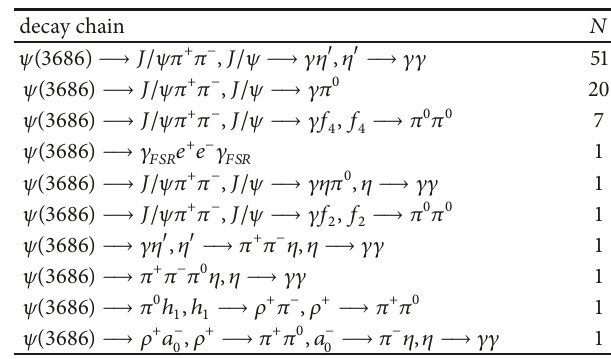
Table 1: The background of 𝐽/𝜓 󳨀→ 𝛾𝜂, 𝜂 󳨀→ 𝛾𝛾 . 𝑁 denotes the number of events passed from each decay chain.